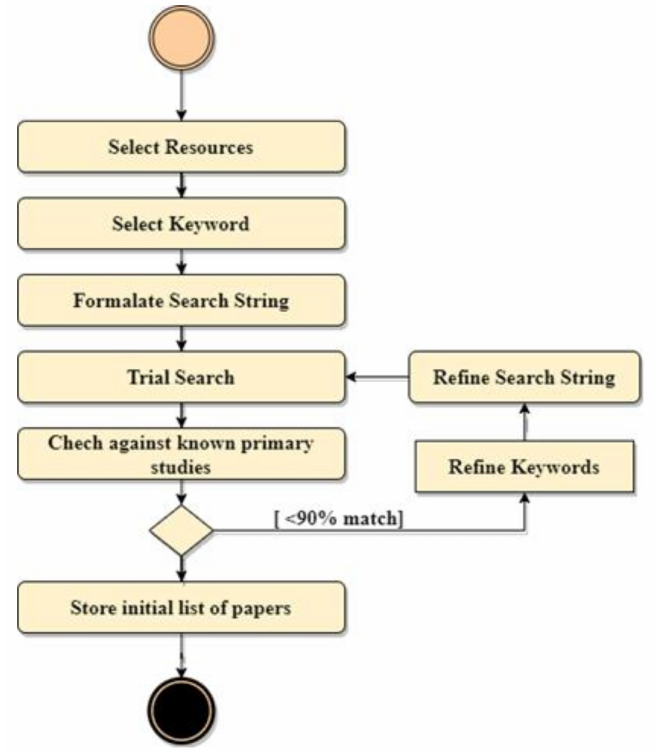
Figure 2. The steps for creating and improving the search